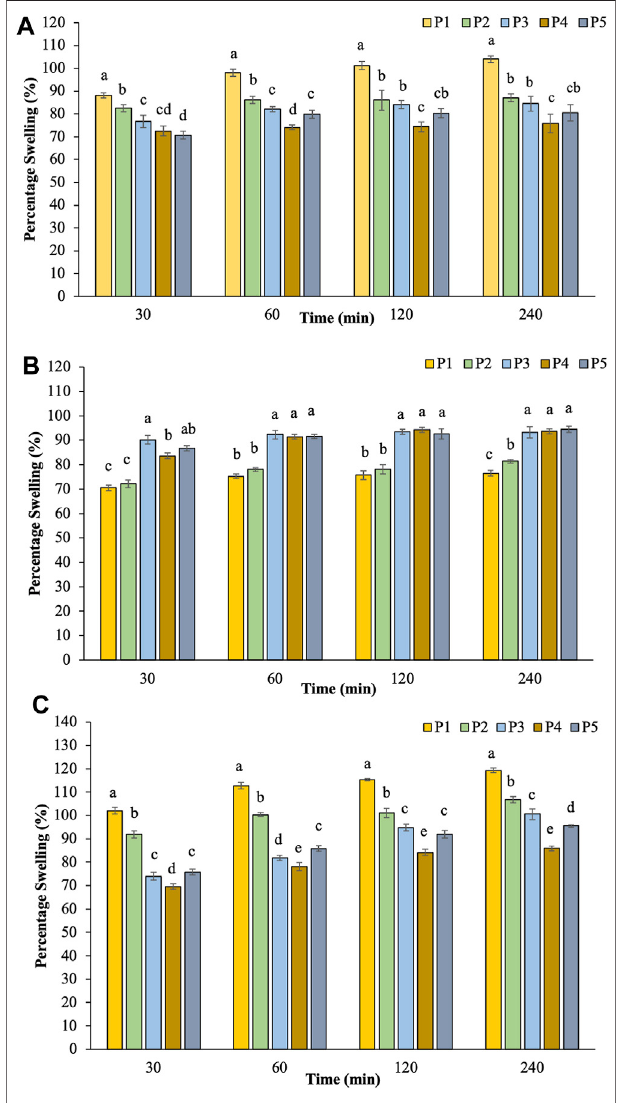
FIGURE 2 | The percentage swelling of hydrogel beads in water (A) , pH 1.2 (B) , and pH 7.4 (C) .